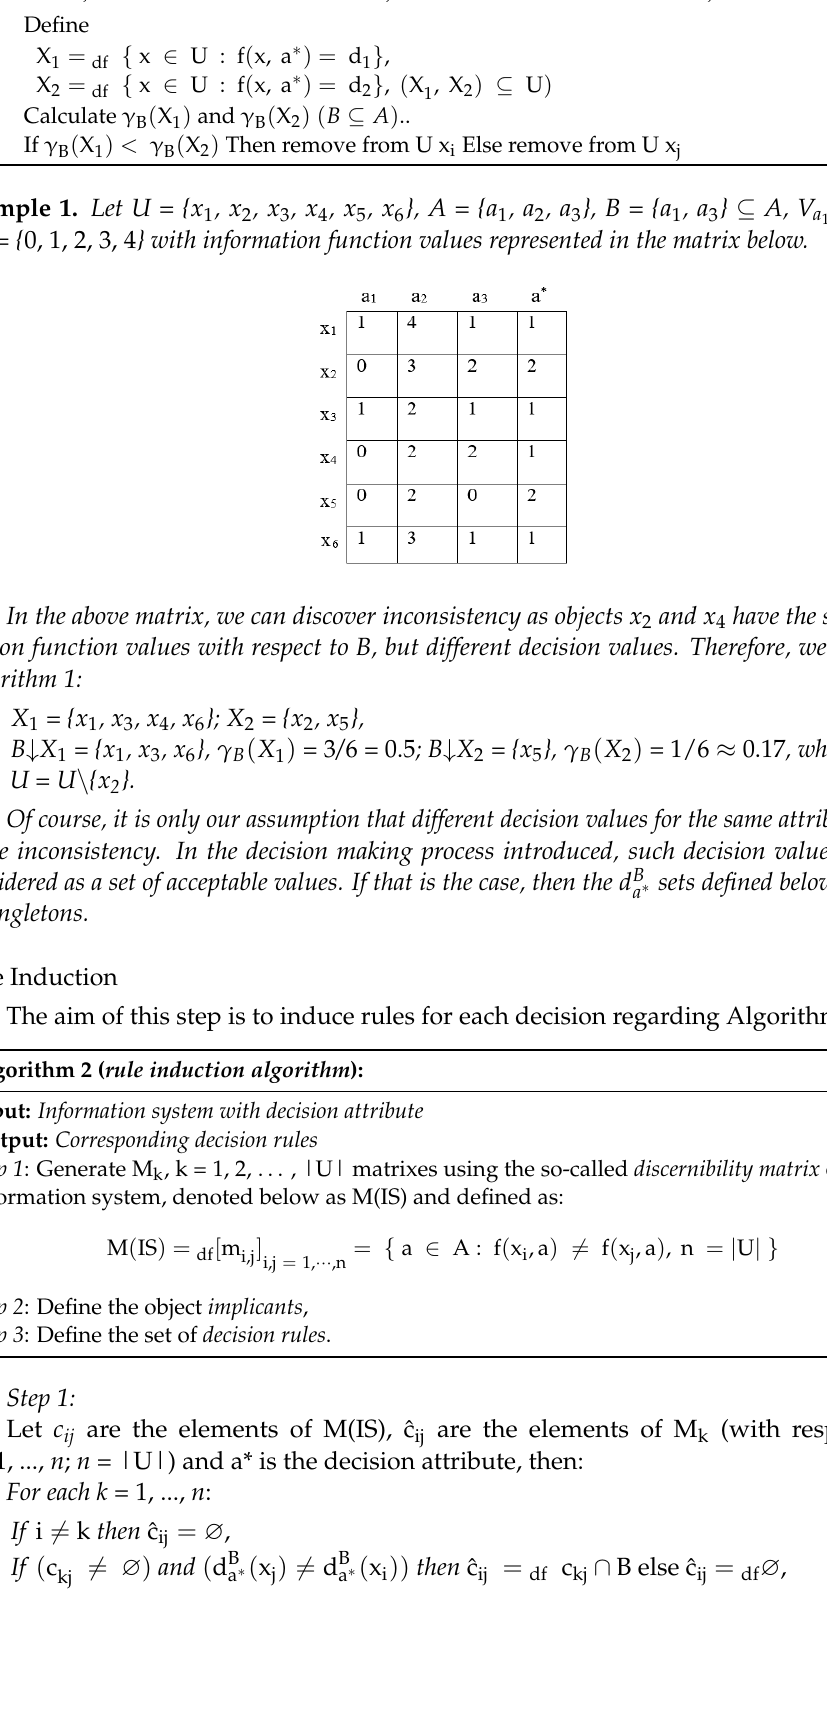
Algorithm 1 ( inconsistency elimination algorithm ):